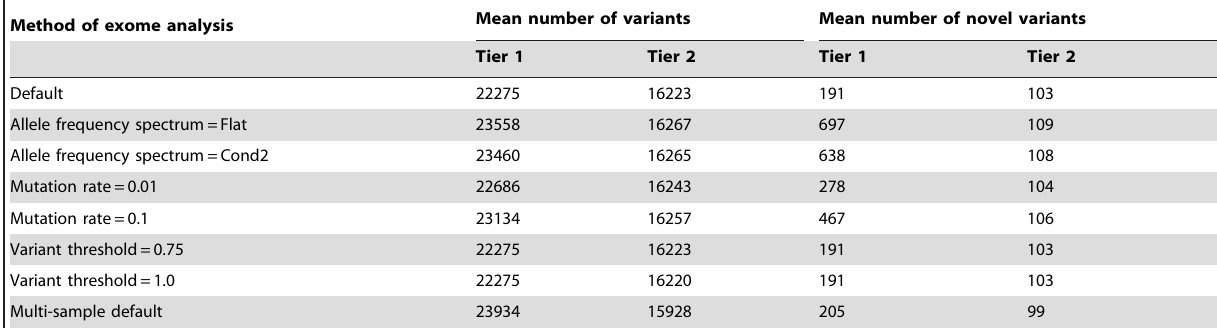
Table 3. Mean number of variants identified.